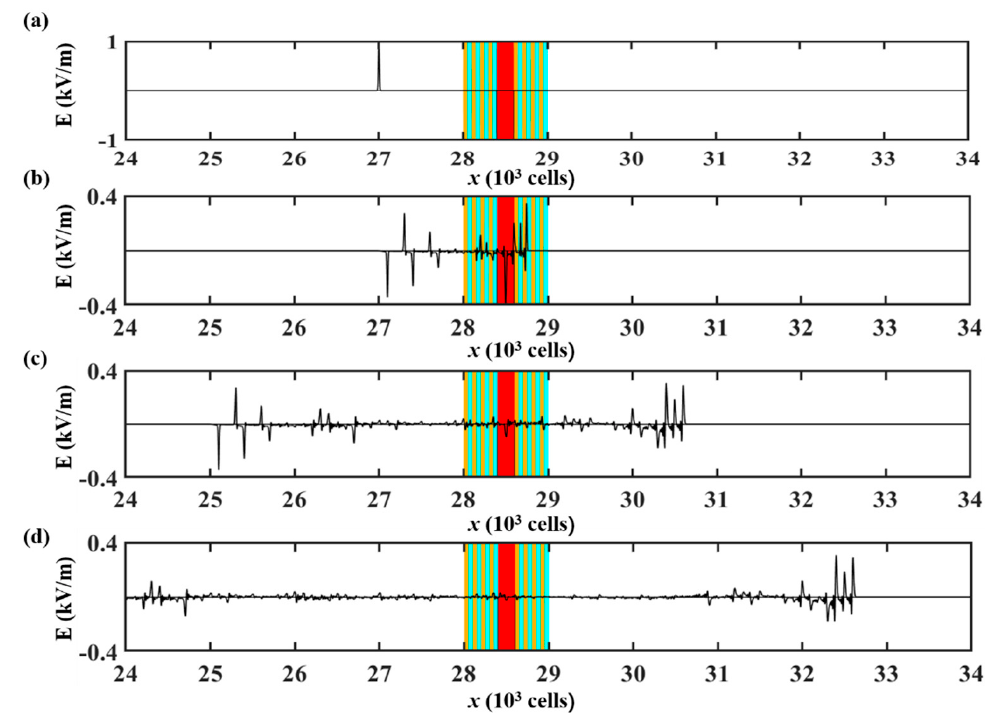
Figure 7. Snapshots of the electric field of an incident Gaussian pulse propagating in air and incident upon a 1D plasma PhC with a defect layer thickness of DL = 2 d at different times: ( a ) 0, ( b ) 15.3, ( c ) 30.6, and ( d ) 45.9 fs. The properties of the plasma layer are ω p = 2.0 THz, ϑ c = 50 GHz.